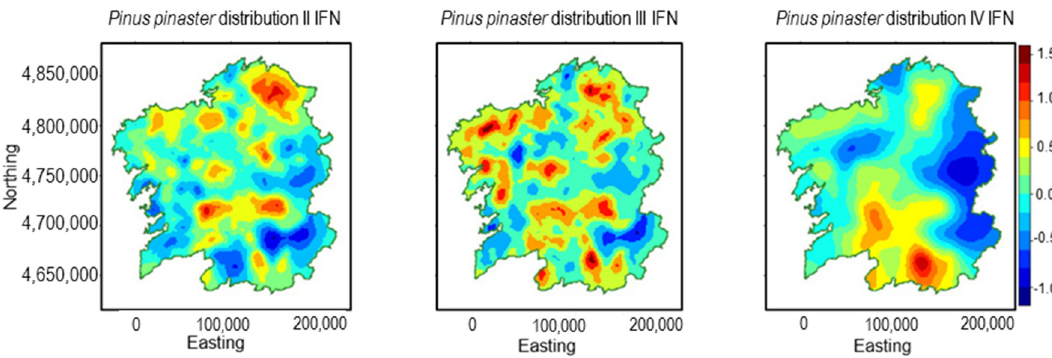
Figure 7. Maps of the posterior mean of the spatial field from the spatial model of P. pinaster , II, III, and IV forest inventories (coordinates in m.).